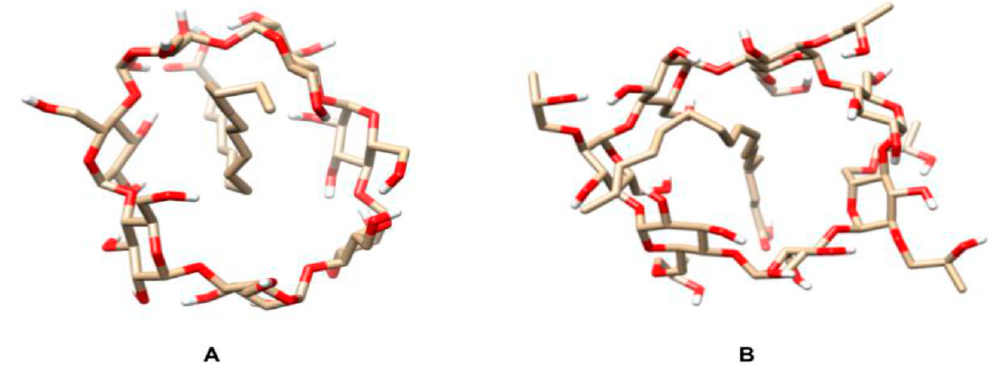
Figure 1. Schematic representation of the inclusion complexes of oleic acid with β -cyclodextrin ( β -CD) and hydroxy-propyl- β -cyclodextrin (HP- β -CD). ( A ) β -CD-oleic acid and ( B ) HP- β -CD-oleic acid, with interaction energies of − 41.28 ± 0.57 kJ/mol and 25.15 ± 0.44 kJ/mol, respectively. Images were obtained using the UCSF-Chimera software [31].